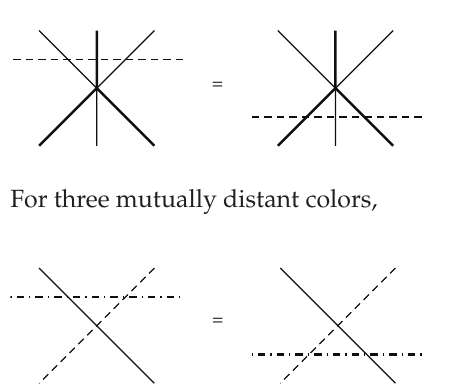
For two adjacent colors and a third, distant to both,